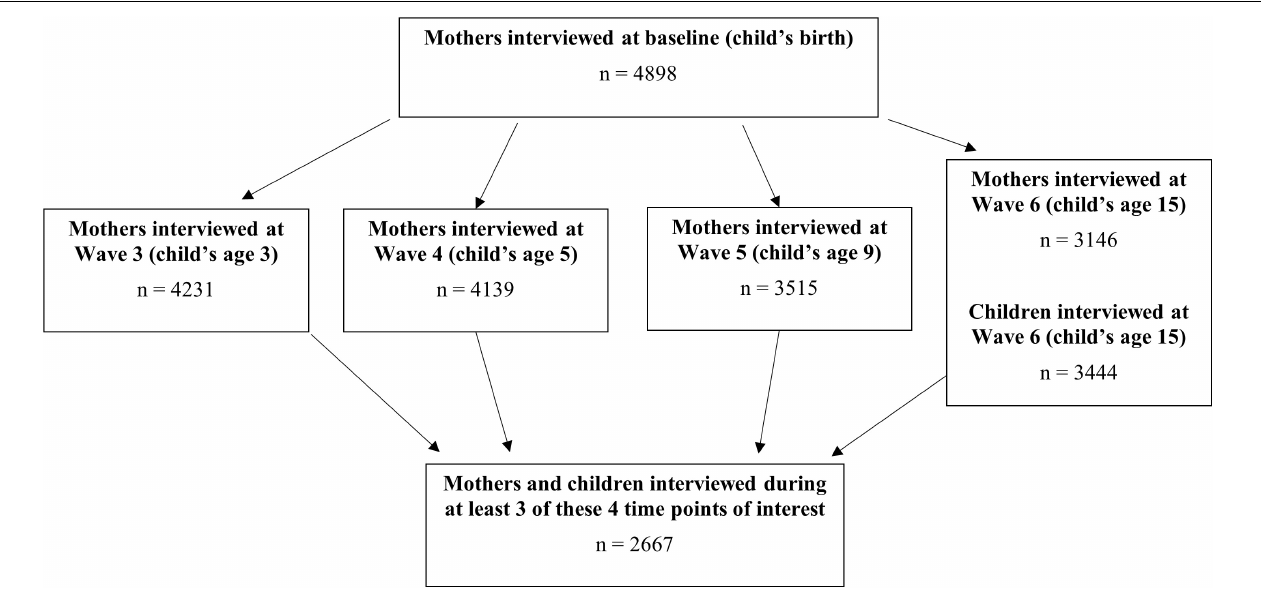
FIGURE 1 | Flow diagram depicting analytic sample of